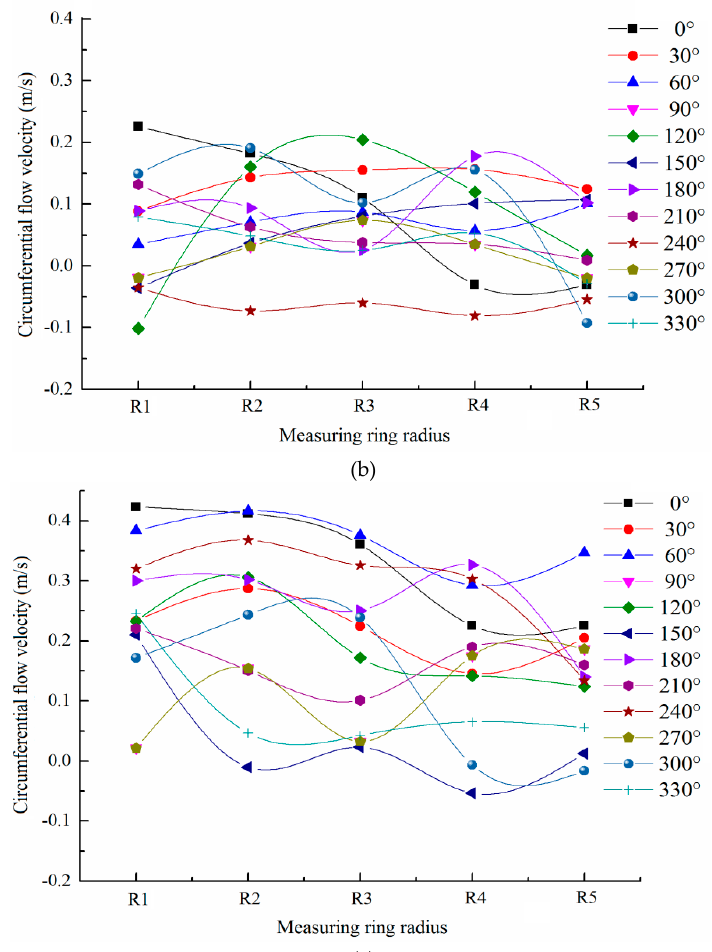
Figure 15. Circumferential velocity of the same polar axis: ( a ) rear section; ( b ) middle section; and ( c ) front section.